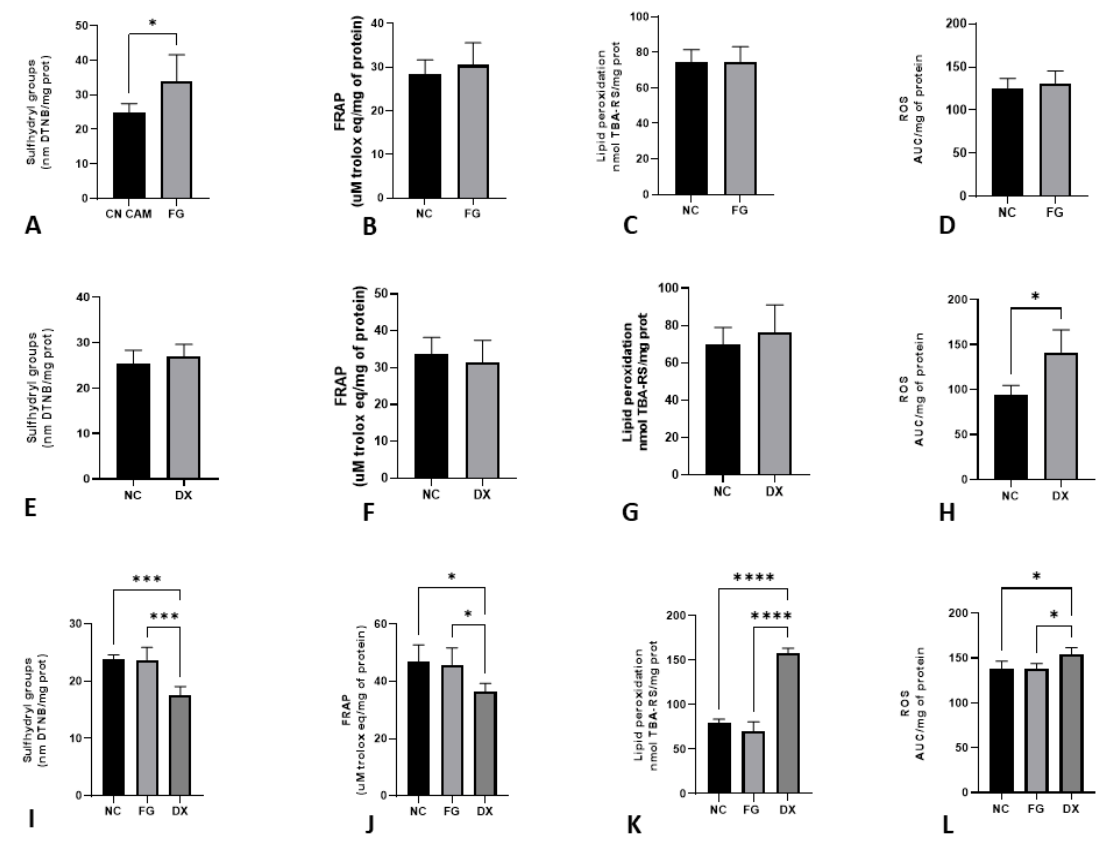
Figure 4. Levels of oxidative stress biomarkers in terms of sulfhydryl groups ( A ), FRAP ( B ), lipid peroxidation ( C ) and ROS production ( D ) in chicken embryos’ livers after inoculation with FG via CAM at 10 EID; sulfhydryl groups ( E ), FRAP ( F ), lipid peroxidation ( G ) and ROS production ( H ) in chicken embryos’ livers after inoculation with DX via SM at 10 EID; sulfhydryl groups ( I ), FRAP ( J ), lipid peroxidation ( K ) and ROS production ( L ) in chicken embryos’ livers after inoculation with FG and DX via SM in 12 EID. The asterisks symbols indicate a statistical difference between the groups (* = p ≤ 0.05; *** = p ≤ 0.001; **** = p ≤ 0.0001). FRAP: ferric reducing antioxidant power. ROS: Reactive oxygen species. NC: Negative control. FG: Filgrastim. DX: